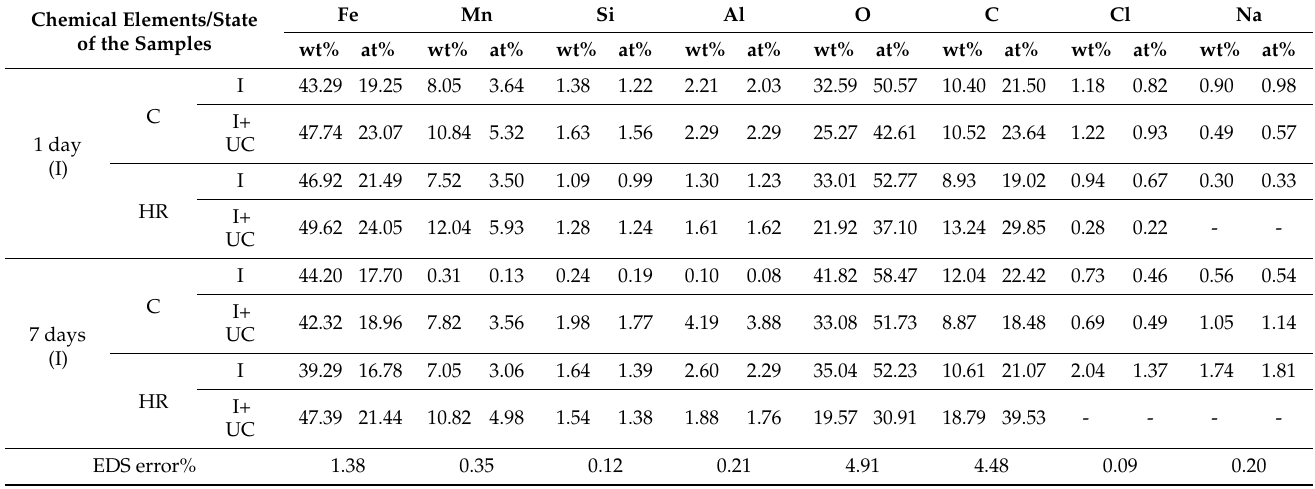
Table 5. EDS analysis after the immersion tests and ultrasound cleaning (immersion time for 1 and 7